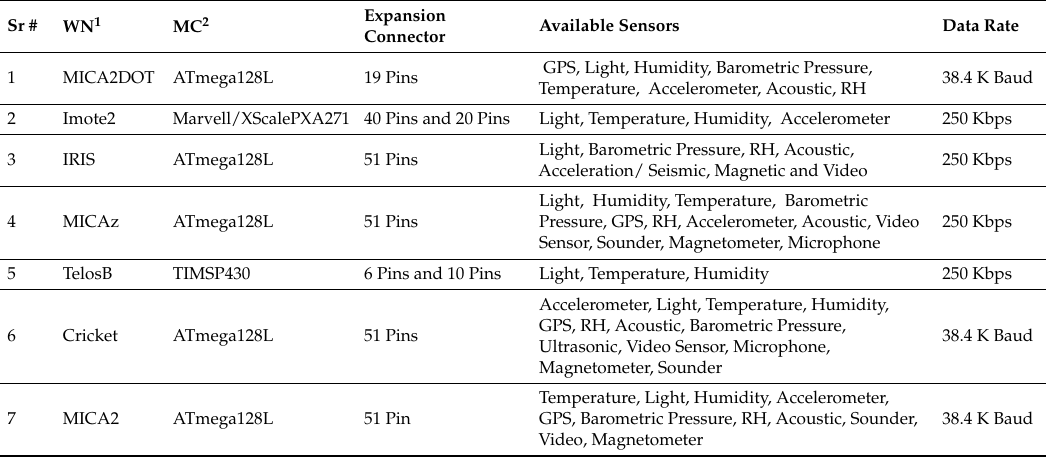
Table 2. Common wireless nodes used in the agriculture